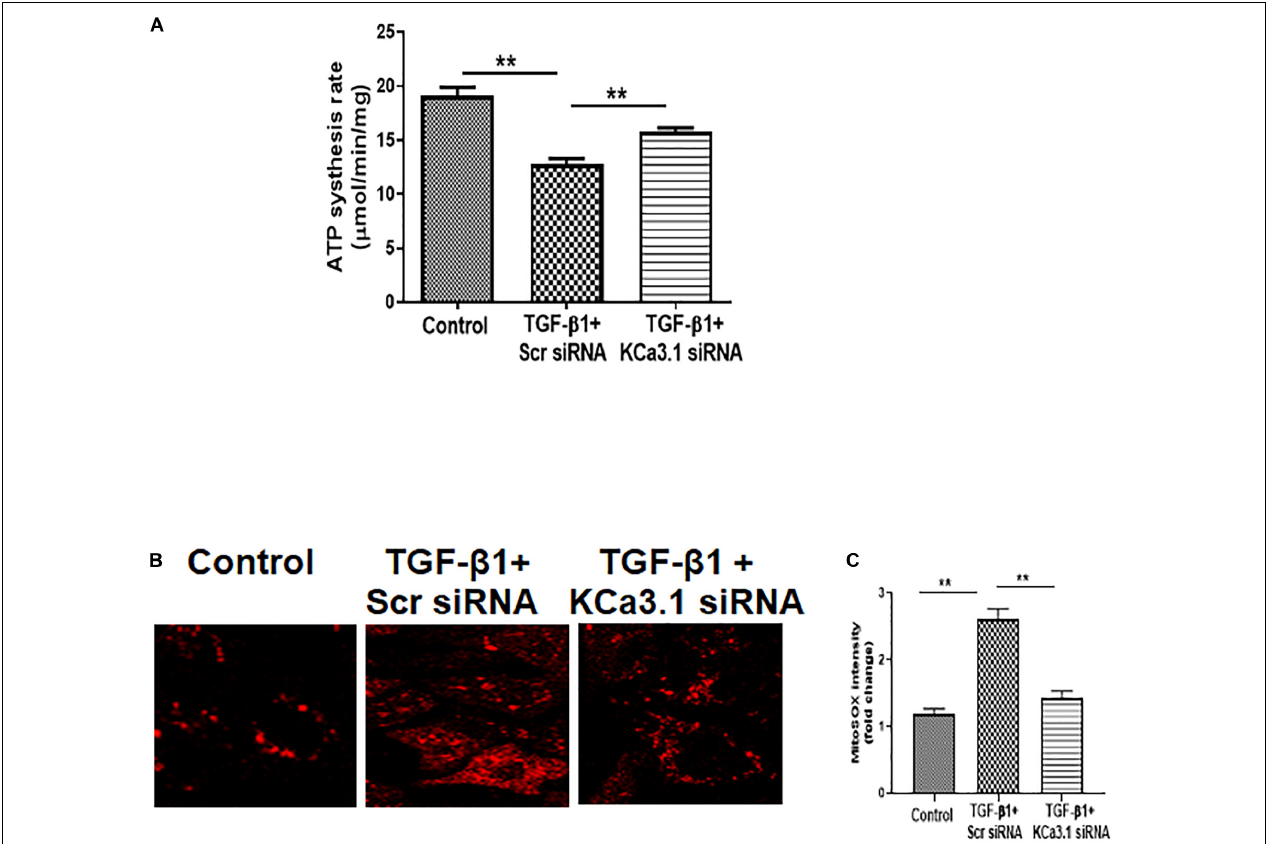
FIGURE 1 | KCa3.1 gene silencing reversed TGF- β 1-induced mitochondrial dysfunction in HK2 cells. (A) Mitochondrial ATP production rate was assessed to detect mitochondrial function. KCa3.1 silencing significantly increased TGF- β 1-induced inhibition of ATP production rate. (B) Mitochondrial reactive oxygen species (mtROS) production was assessed by MitoSOX Red staining. KCa3.1 silencing significantly reduced TGF- β 1-induced mtROS overproduction. (C) Quantification of MitoSOX Red fluorescence intensity normalized to the control group in HK2 cells. Results are presented as mean ± SEM. ** P < 0.01. N = 3. Original magnification: ×